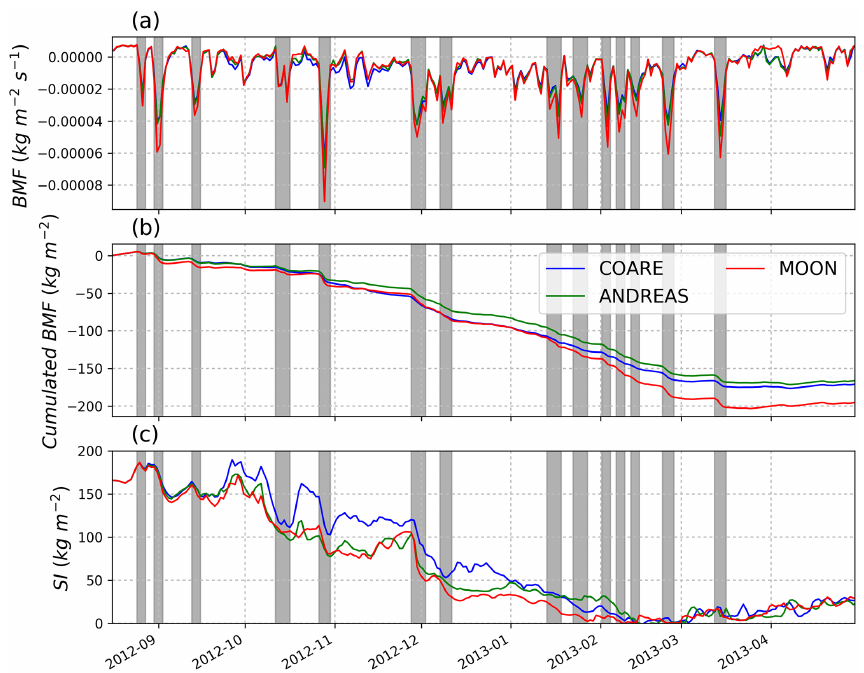
Figure 7. Time series of (a) instantaneous buoyancy mass fluxes, (b) cumulated buoyancy mass fluxes (Eq. 5) and (c) stratification index (Eq. 4) relative to 2000m at the Lion buoy computed for each simulation (COARE in blue, ANDREAS in green and MOON in red). The grey bars correspond to the strong wind periods (hourly wind speed > 15ms − 1